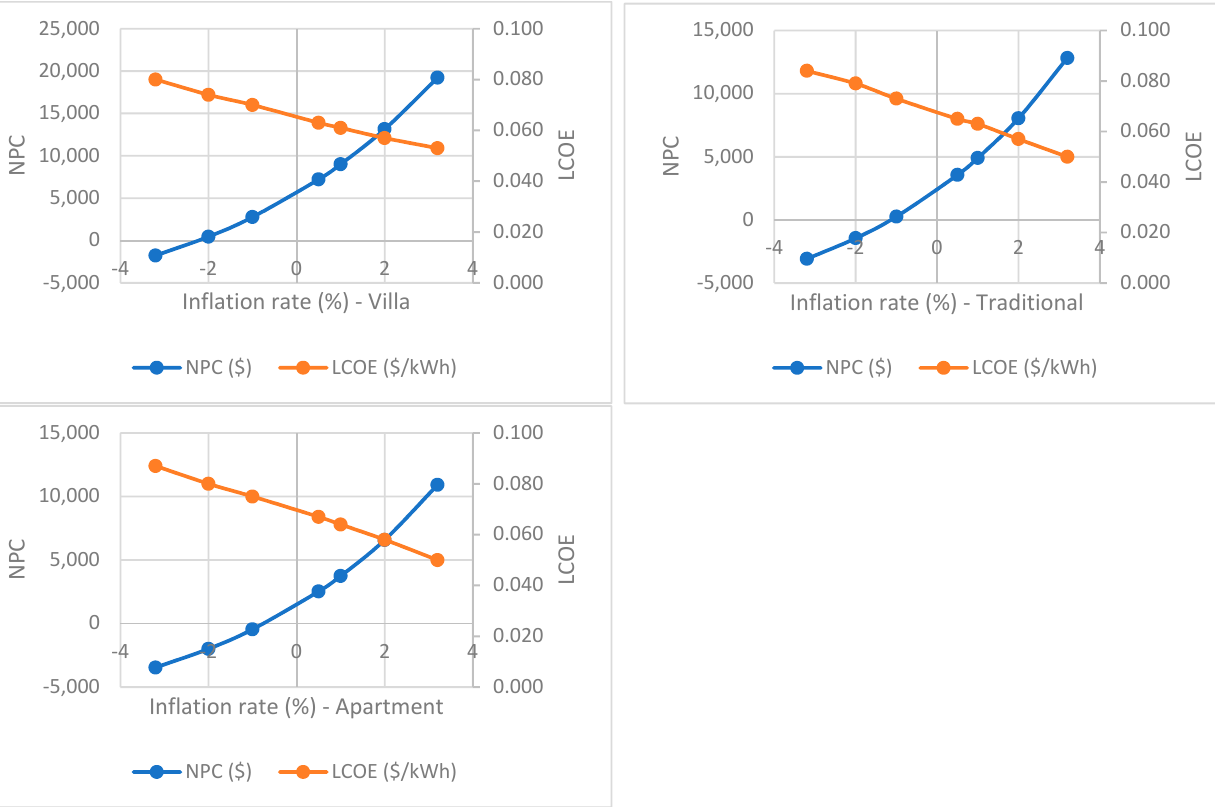
Figure 9. Effect of inflation rate on NPC and LCOE for villa, traditional dwelling, and apartment.